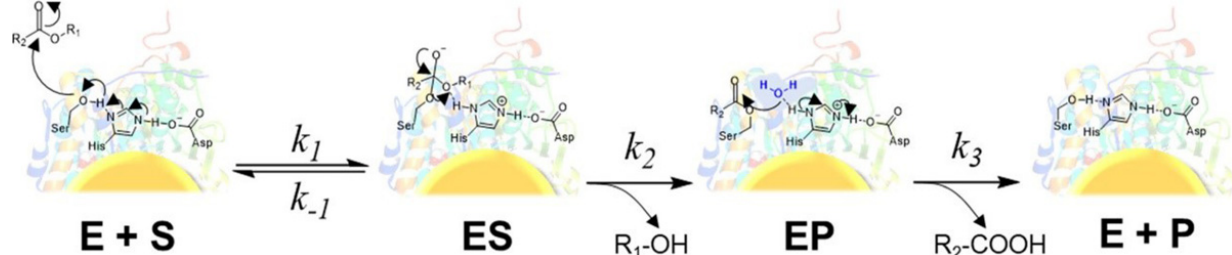
Figure 2. The mechanism of hydrolysis reaction catalyzed by a lipase. Reprinted with permission from de Barros et al., American Chemical Society [14].